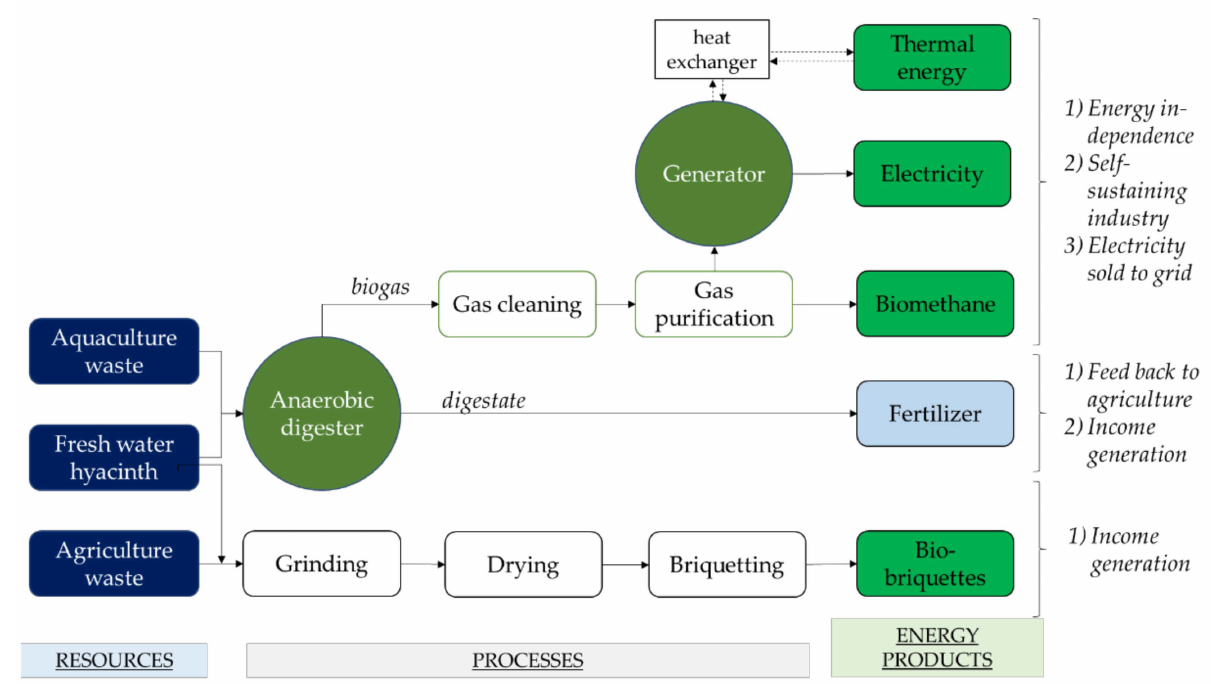
Figure 5. Bioenergy production for uptake by rural